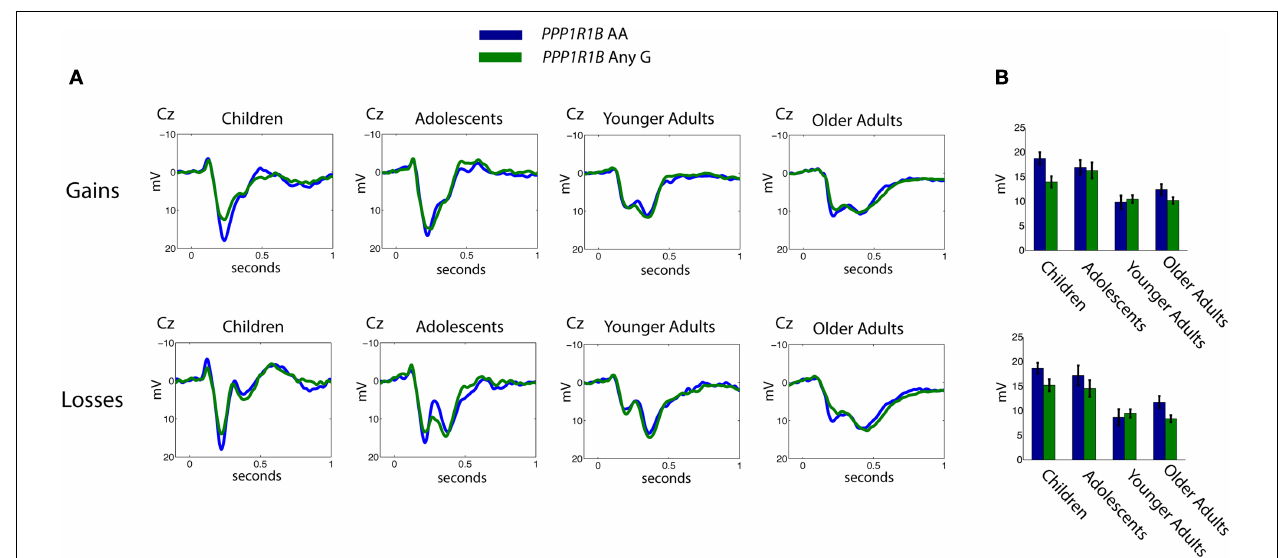
across the four age groups. (B) Inserts indicate mean amplitude for each age group of the individually defined P2 peak at electrode Cz. Error bars denote 1 SE of the mean.